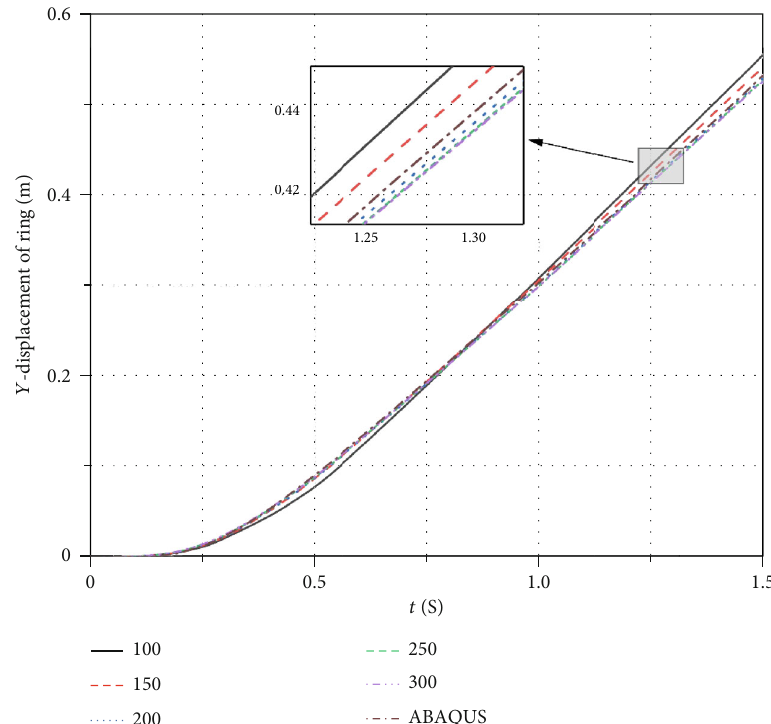
Figure 8: Displacement of the ring on Y -axis.